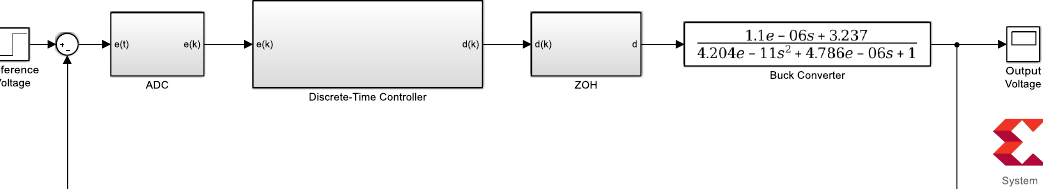
Figure 11. Closed loop representing hardware/software co-simulation.